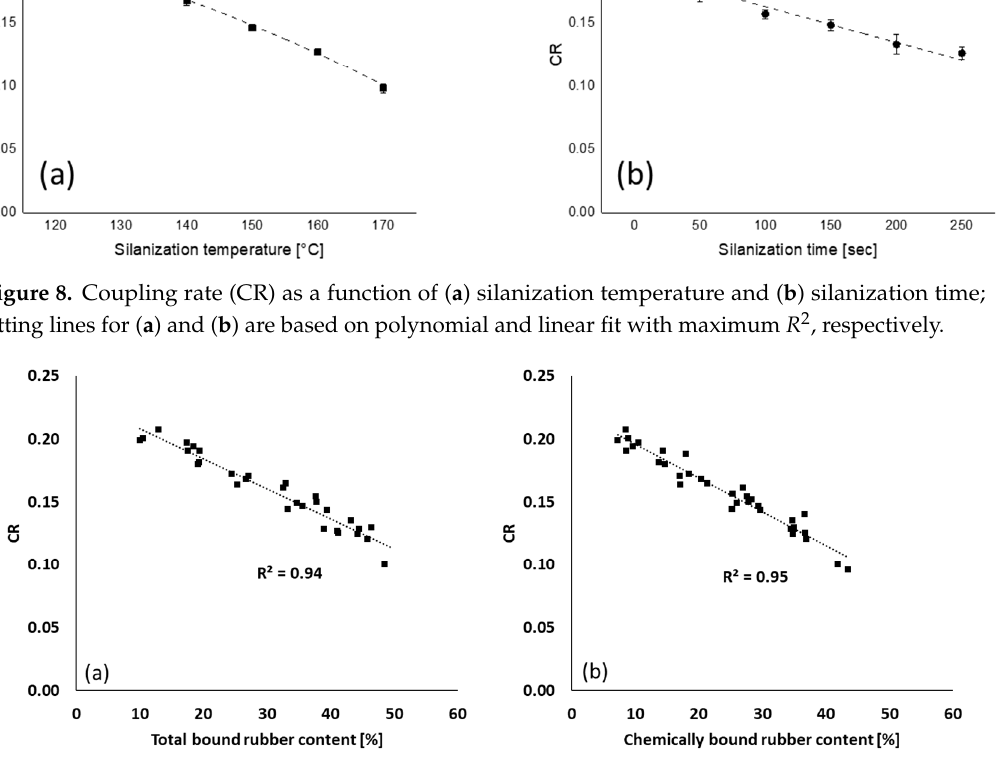
Figure 8. Coupling rate (CR) as a function of ( a ) silanization temperature and ( b ) silanization time; fitting lines for ( a ) and ( b ) are based on polynomial and linear fit with maximum R 2 , respectively.